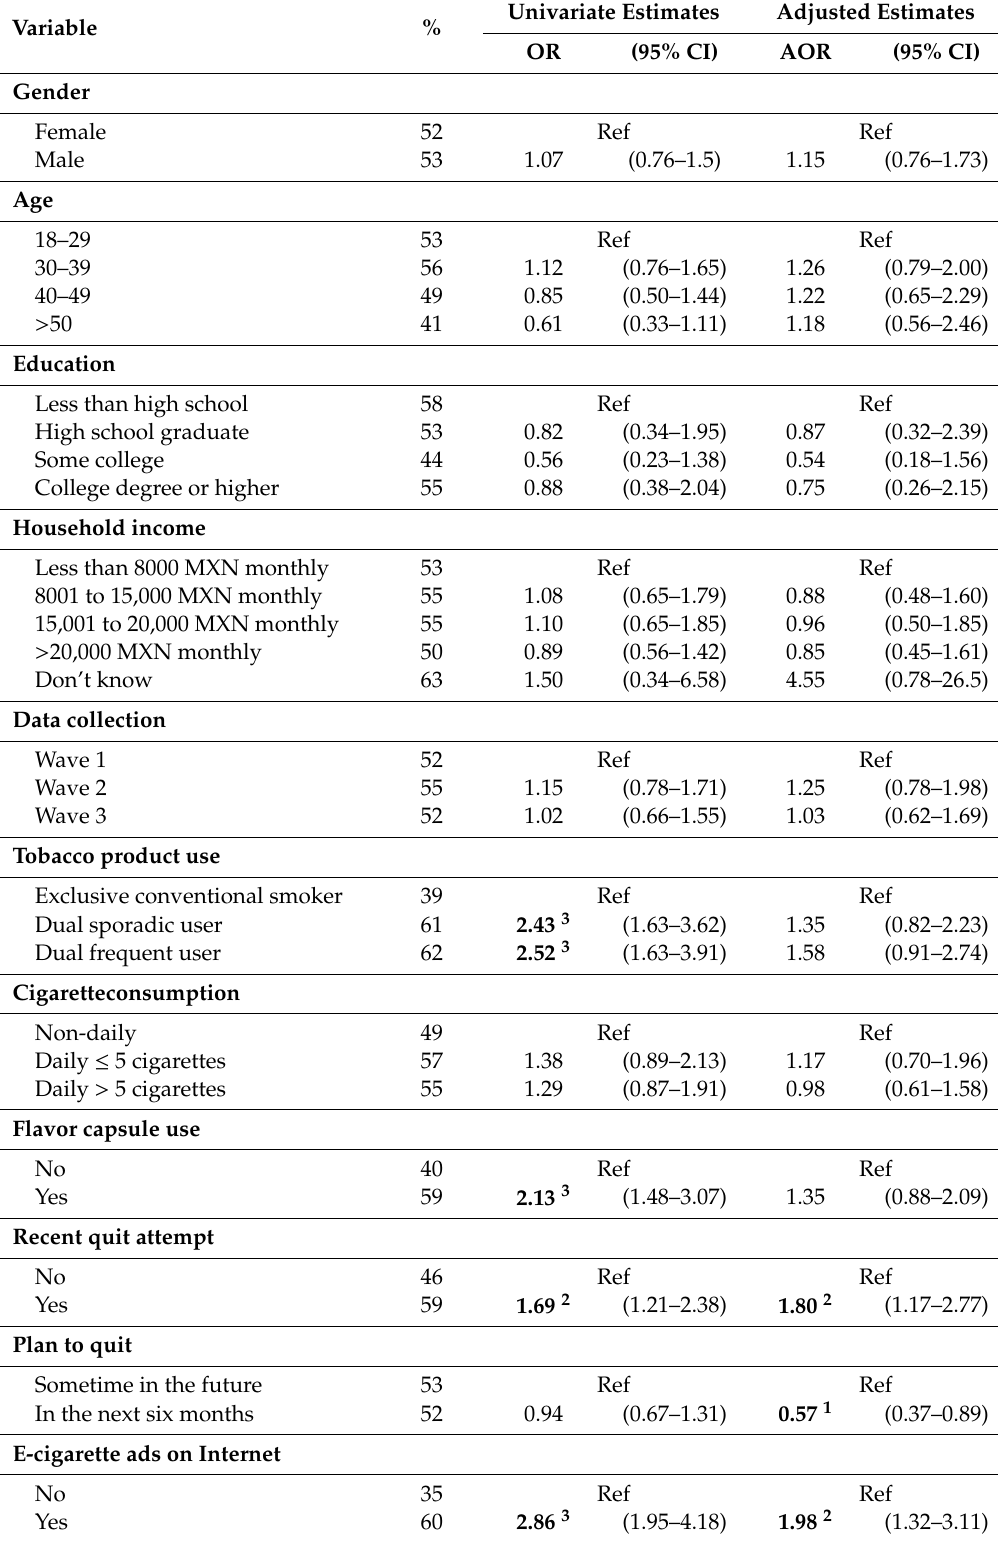
Table 3. Factors associated with having seen heated tobacco products (HTPs) for sale, among adult smokers who were aware of HTPs ( n =